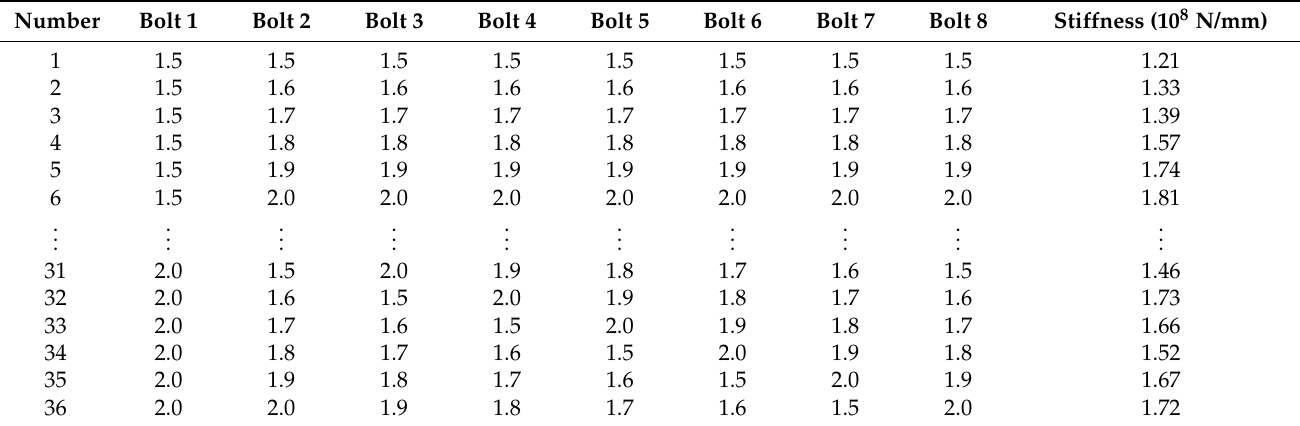
Table 6. Stiffness calculation results (unit: N ·